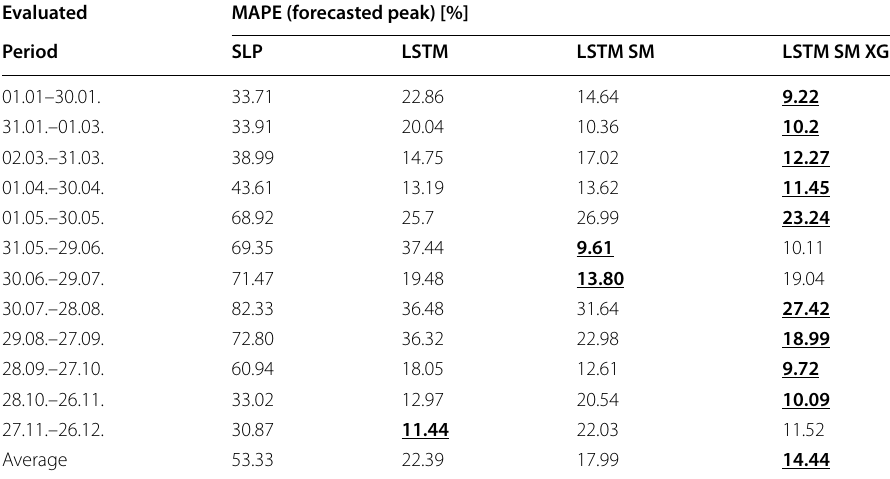
Table 9 MAPE results by periods, for accuracy of forecasted peaks Evaluated MAPE (forecasted peak) [%]